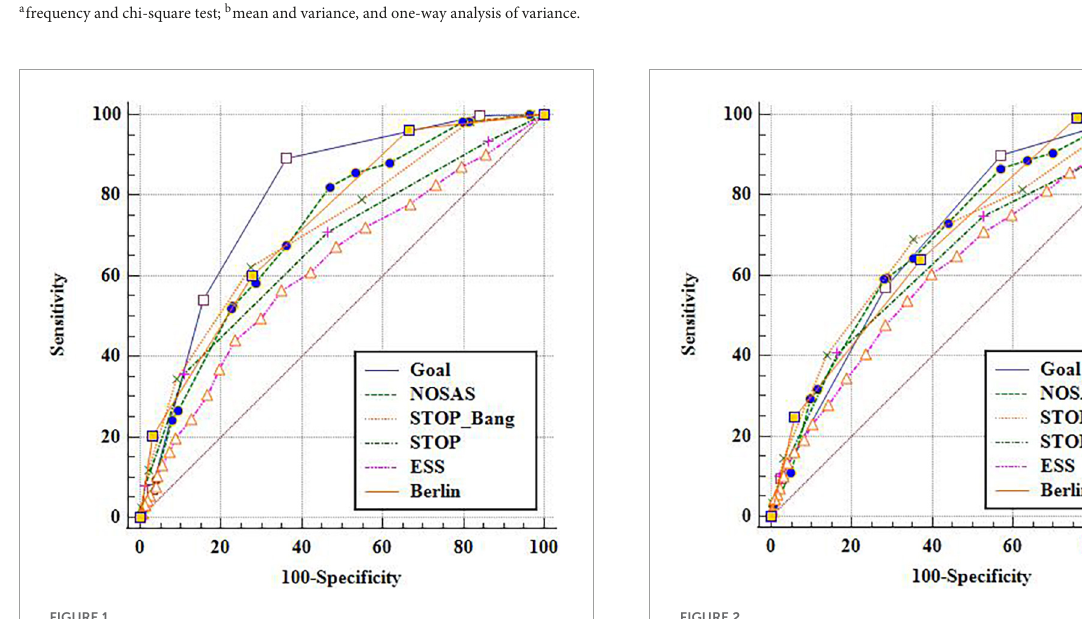
0.719 (0.700–0.738), and 0.734 (0.715–0.752) respectively (see